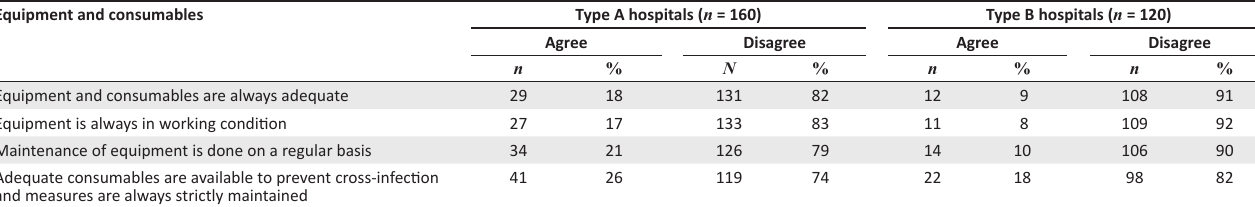
TABLE 4: Equipment and consumables. Equipment and